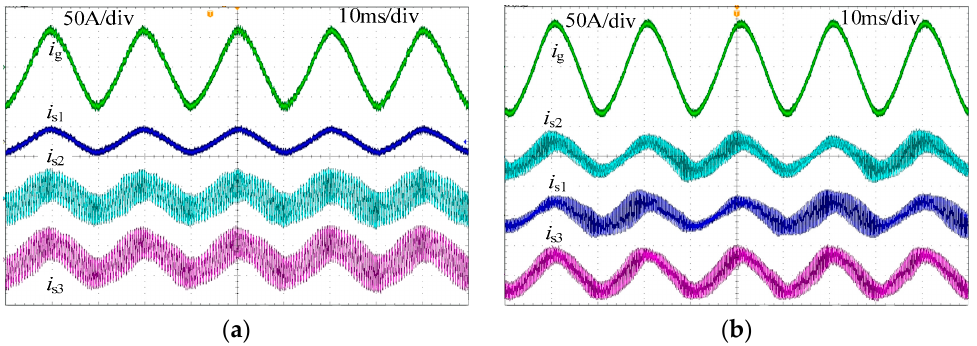
Figure 12. Experimental current waveforms of System II and System III: ( a ) stat-D; ( b ) stat-E.